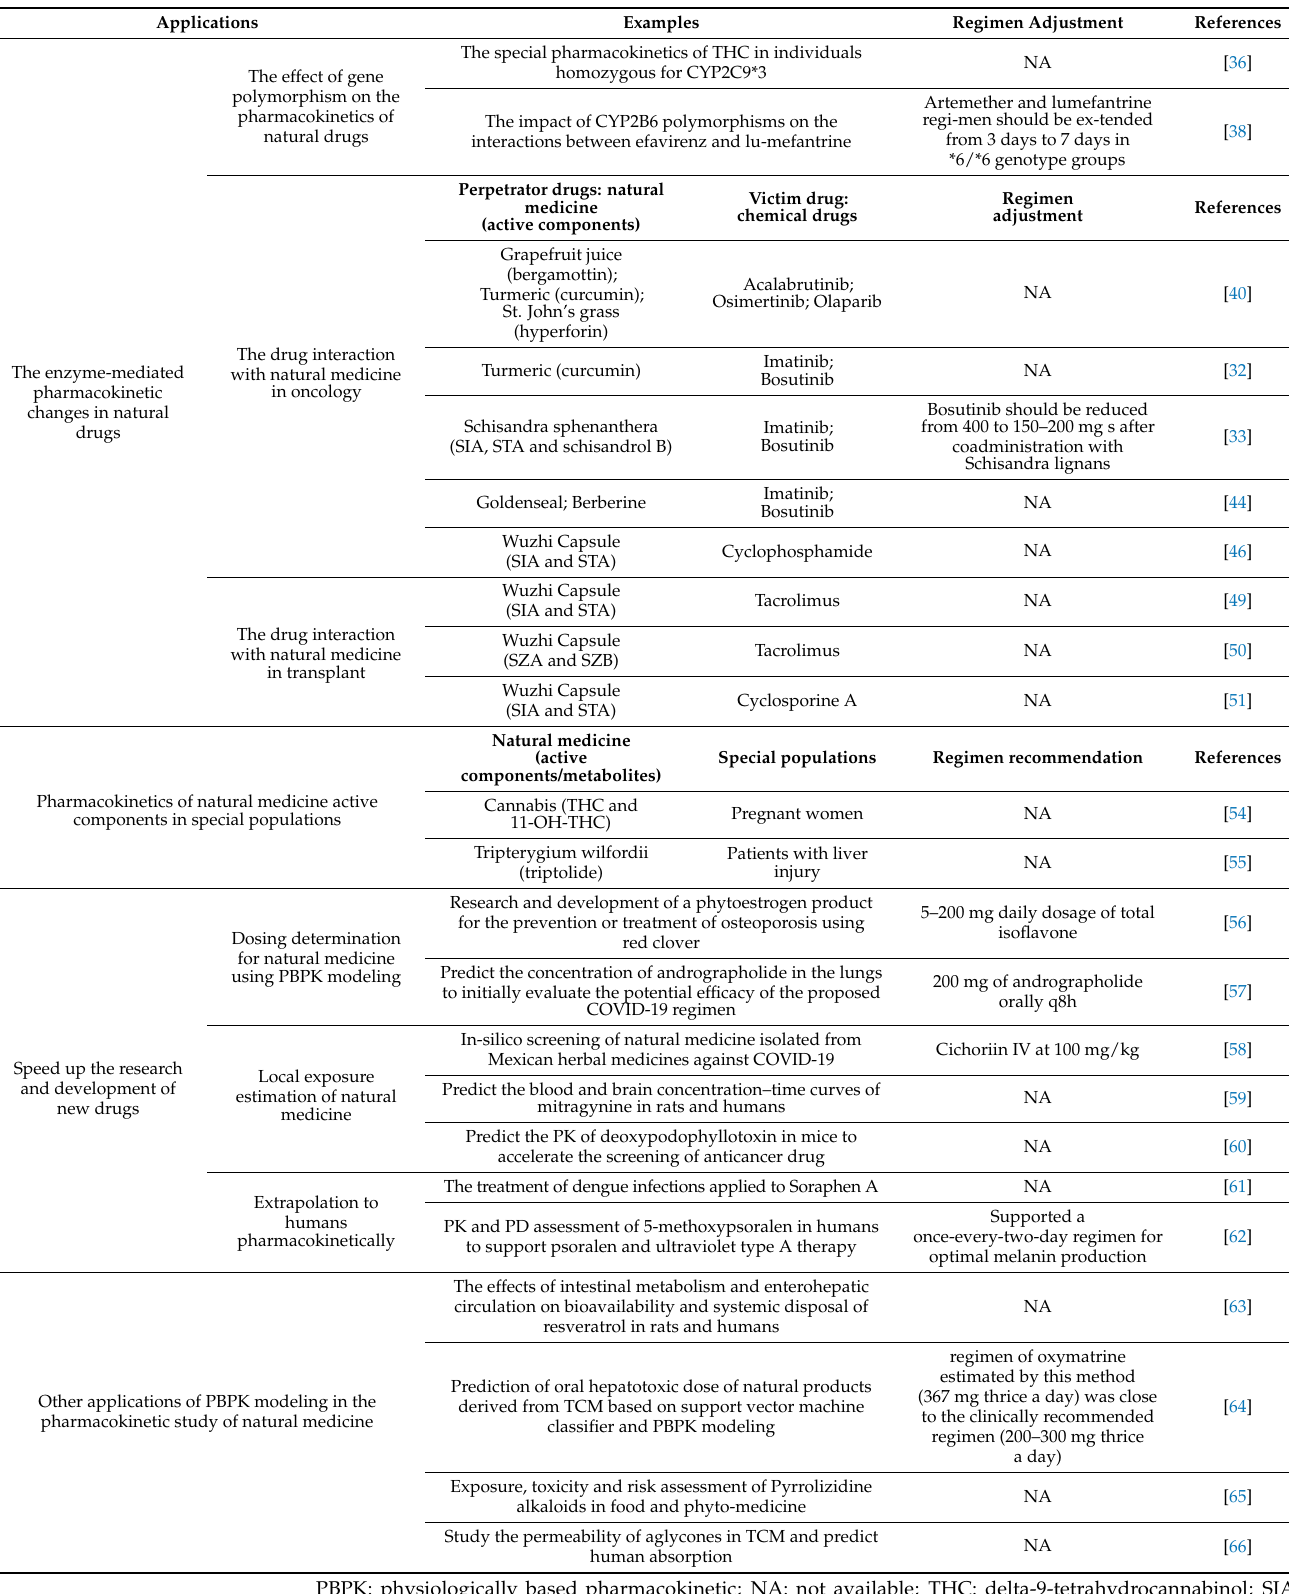
Table 1. Applying the PBPK model in the studies of the pharmacokinetics of natural